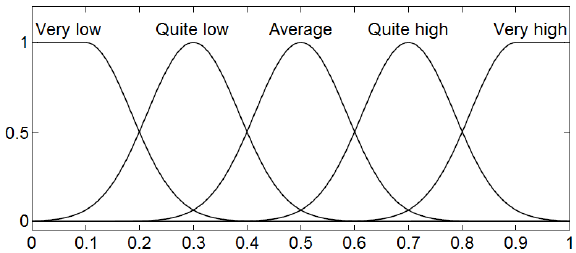
Figure 4: Membership function for the input variable x 1 – PR(Uph) , Gaussian functions